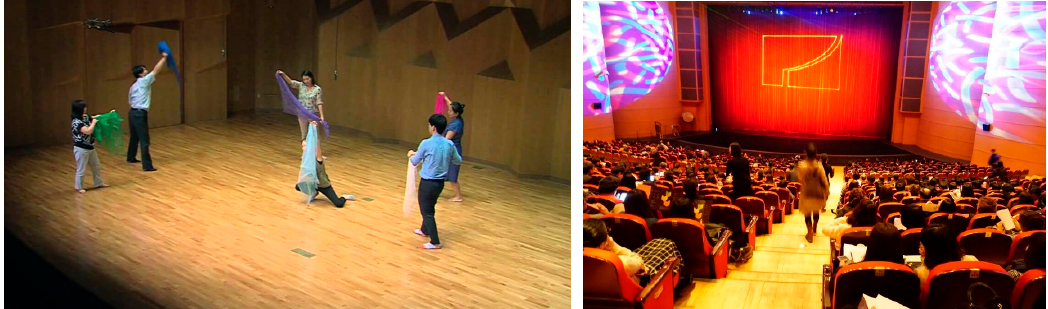
Figure 3. Scene of art healing and arts education for adolescents.